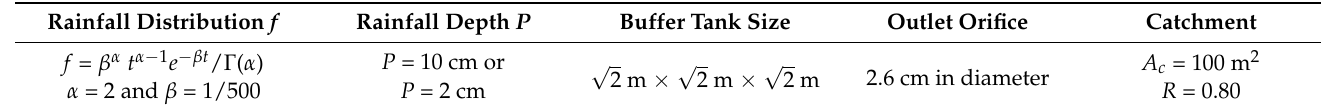
Table 1. Simulation parameters.